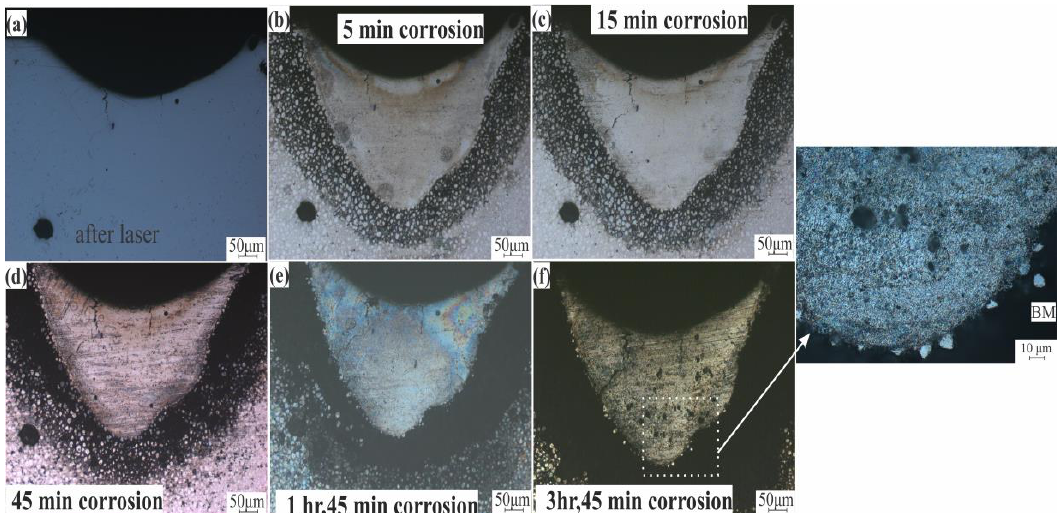
Figure 12. Intergranular corrosion of AA7075-Standard after ( a ) laser, ( b ) 5 min, ( c ) 15 min, ( d ) 45 min, ( e ) 1 h and 45 min, and ( f ) 3 h and 45 min.